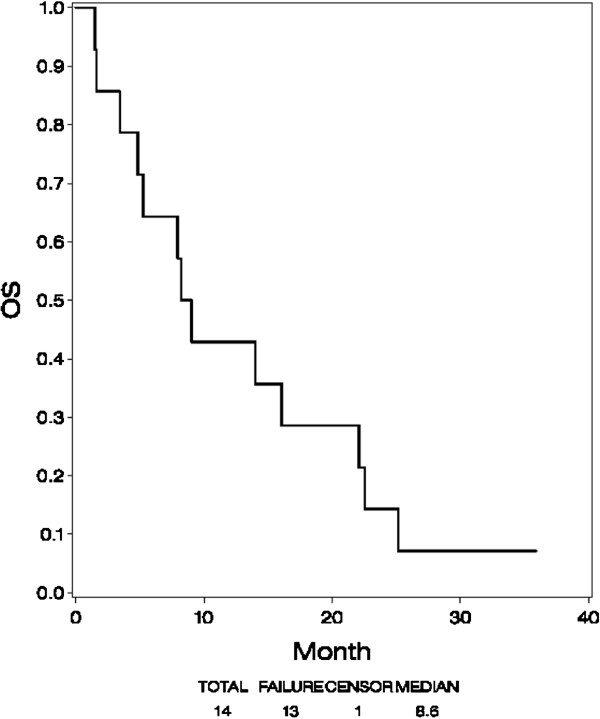
Overall survival (OS).